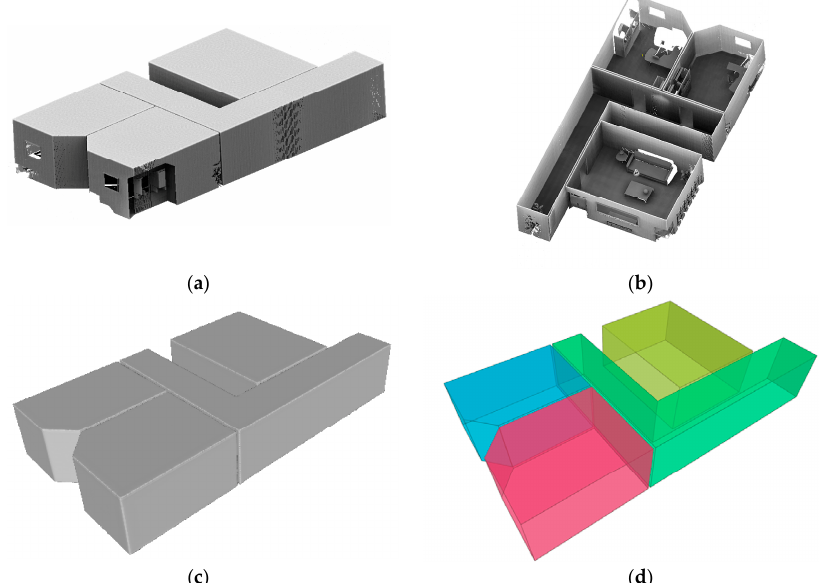
Figure 10. Models reconstructed from the synthetic dataset: ( a ) raw point cloud dataset, ( b ) raw point cloud dataset without ceiling, ( c ) our model, ( d ) reference model.